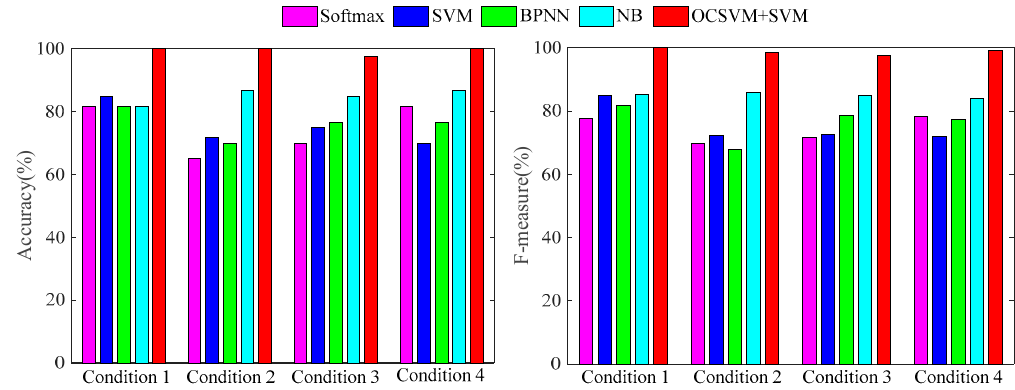
Figure 12. Accuracy and F-measure of first test with different methods.